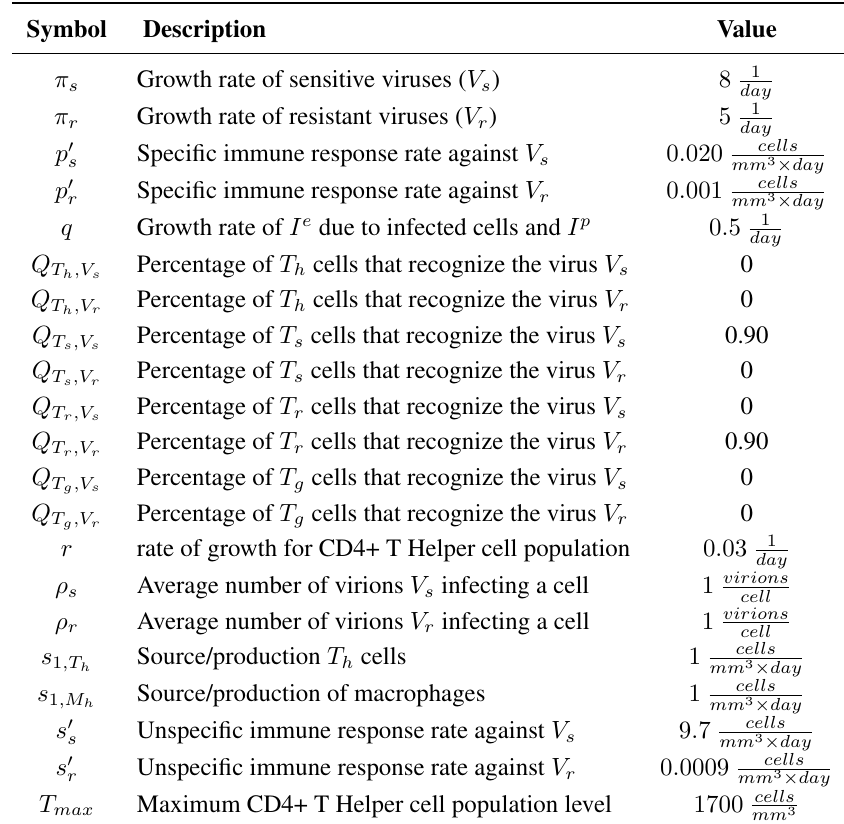
Table B3. Common parameters at both instances (Part 2)